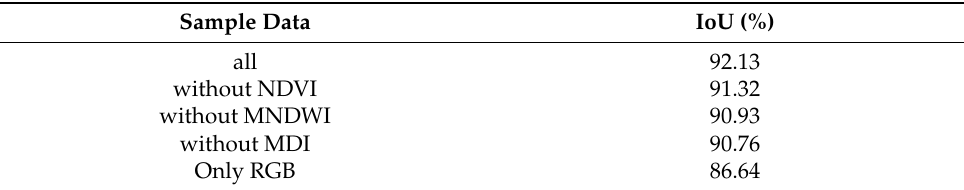
Table 6. Effect of normalization difference vegetation index (NDVI), modified normalized differ- ence water index (MNDWI), and mangrove discrimination index (MDI) on the result of mangrove extraction under the ResNet-based